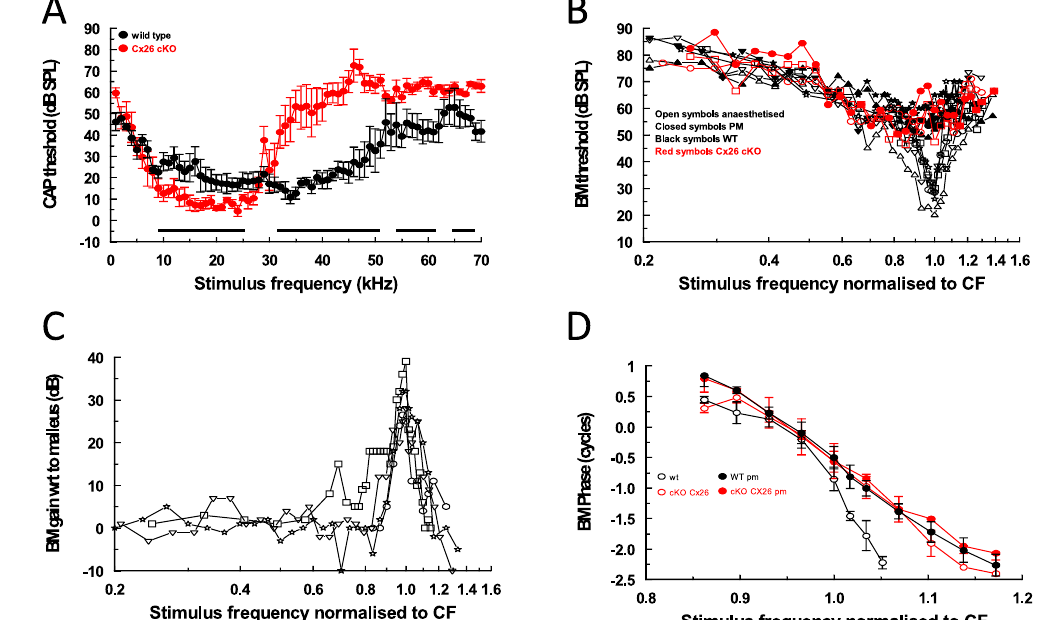
Figure 5. High-frequency hearing is desensitized and detuned and low-mid frequency hearing is sensitized in Cx26 cKO mice. ( A ) Compound action potential (CAP) audiogram (mean ± SD of CAP detection threshold as a function of stimulus frequency) from 5 WT (black symbols) and 5 Cx26 cKO (red symbols) mice. Solid horizontal lines indicate regions where CAP thresholds of WT and Cx26 cKO mice are significantly different (unpaired t-test, 0.05 two-tailed p value). ( B ) Threshold (0.2 nm) frequency tuning curves measured from the 54 kHz–59 kHz frequency region of the basal turn BM from 5WT, and 2 Cx26 cKO mice, anaesthetized and post-mortem. The frequency axes represent the stimulus frequency normalised to the characteristic frequency (CF) of the measurement location. Different symbols indicate different preparations. ( C ) Gain of BM displacement as a function of stimulus frequency (normalised to the CF of the measurement location) relative to malleus displacement for 4 WT mice. ( D ) BM phase as a function of stimulus frequency (normalised to the CF of the measurement location) measured from the 54 kHz–59 kHz frequency region of the basal turn BM from 5WT, and 5 Cx26 cKO mice, anaesthetized and post-mortem. All mice used in the study were 21–26 day